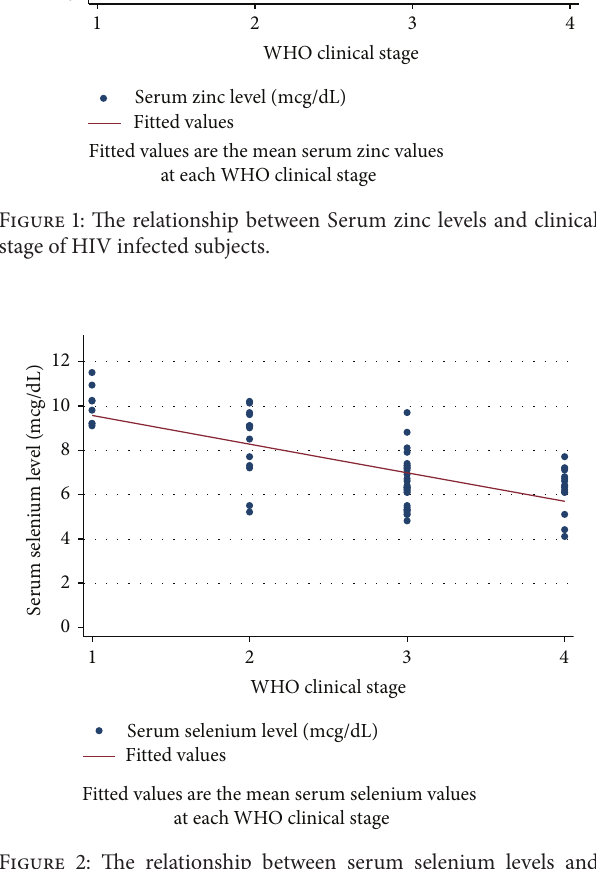
Figure 2: The relationship between serum selenium levels and clinical stage of HIV infected